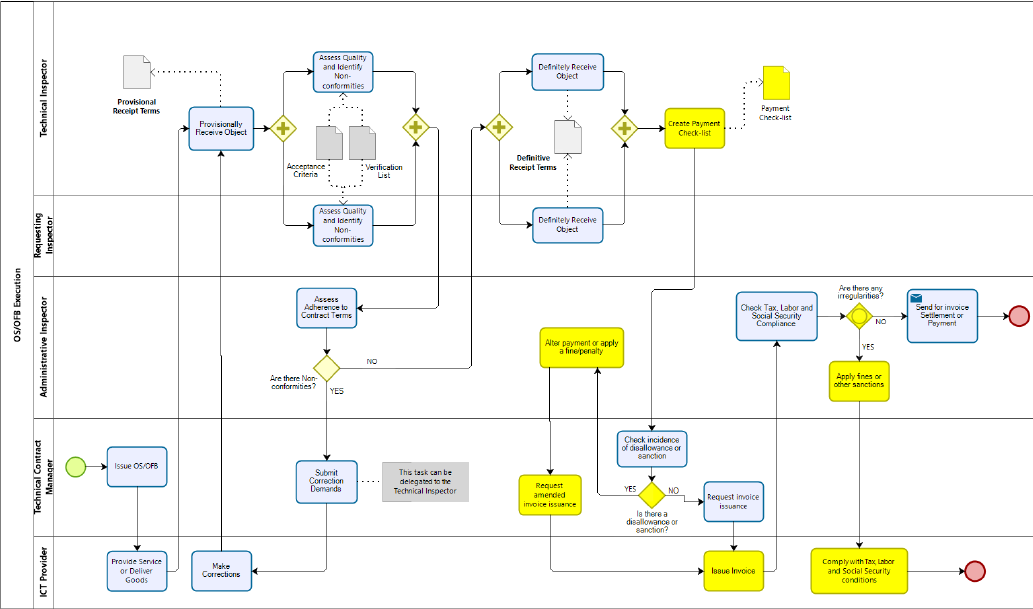
Figure 4. Execution of the OS/OFB with the suggested